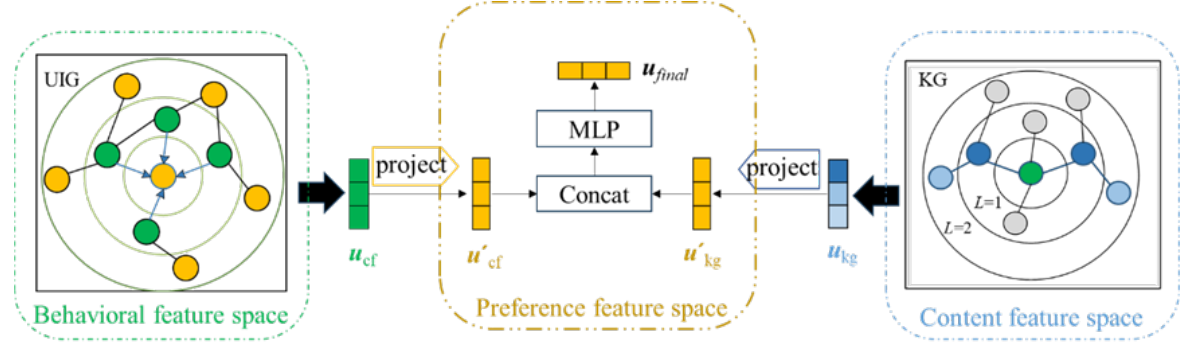
Figure 2. User’s feature modeling process.